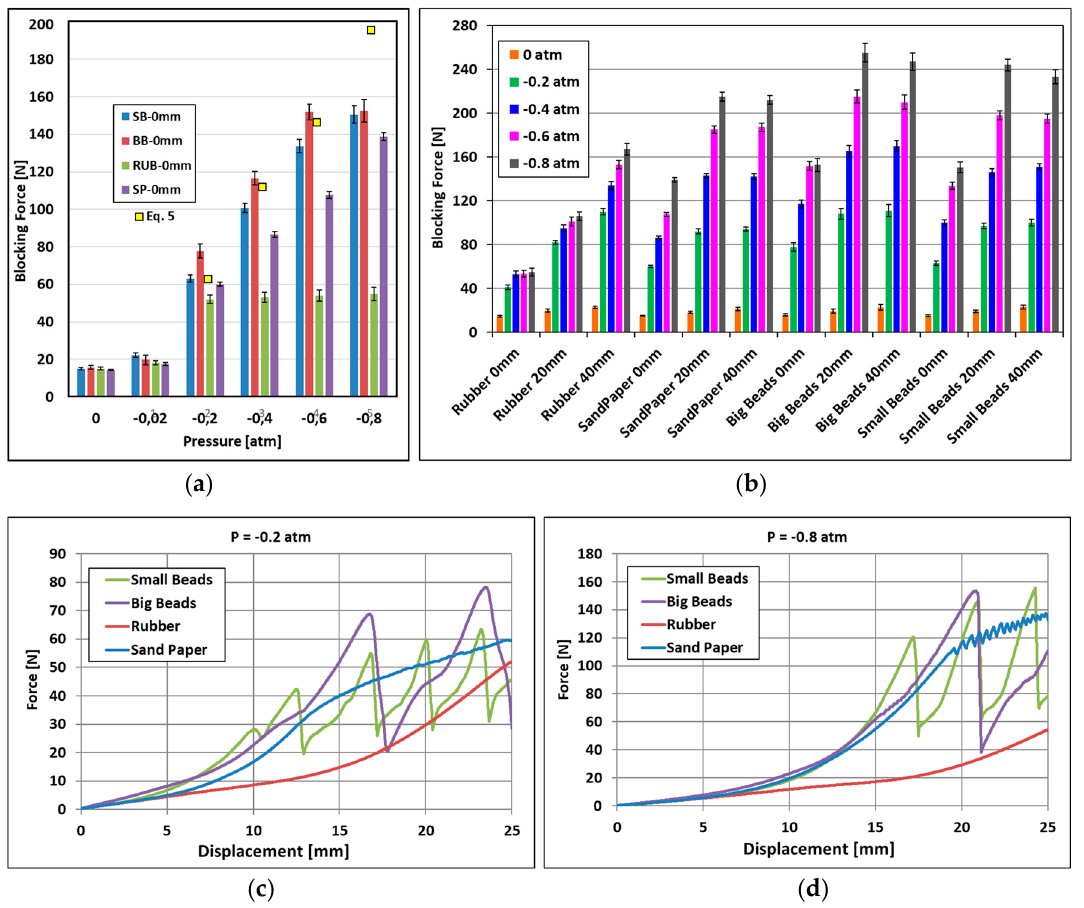
Figure 6. ( a ) The mean maximum withstanding force of all the tested samples, and plot of Equation (5) at the default length and under different applied pressures. ( b ) The withstanding force of all the samples under different applied pressures and different initial elongations. ( c ) The force-displacement graph of all the TBCs under − 0.2 atm, and ( d ) under − 0.8 vacuum pressure.